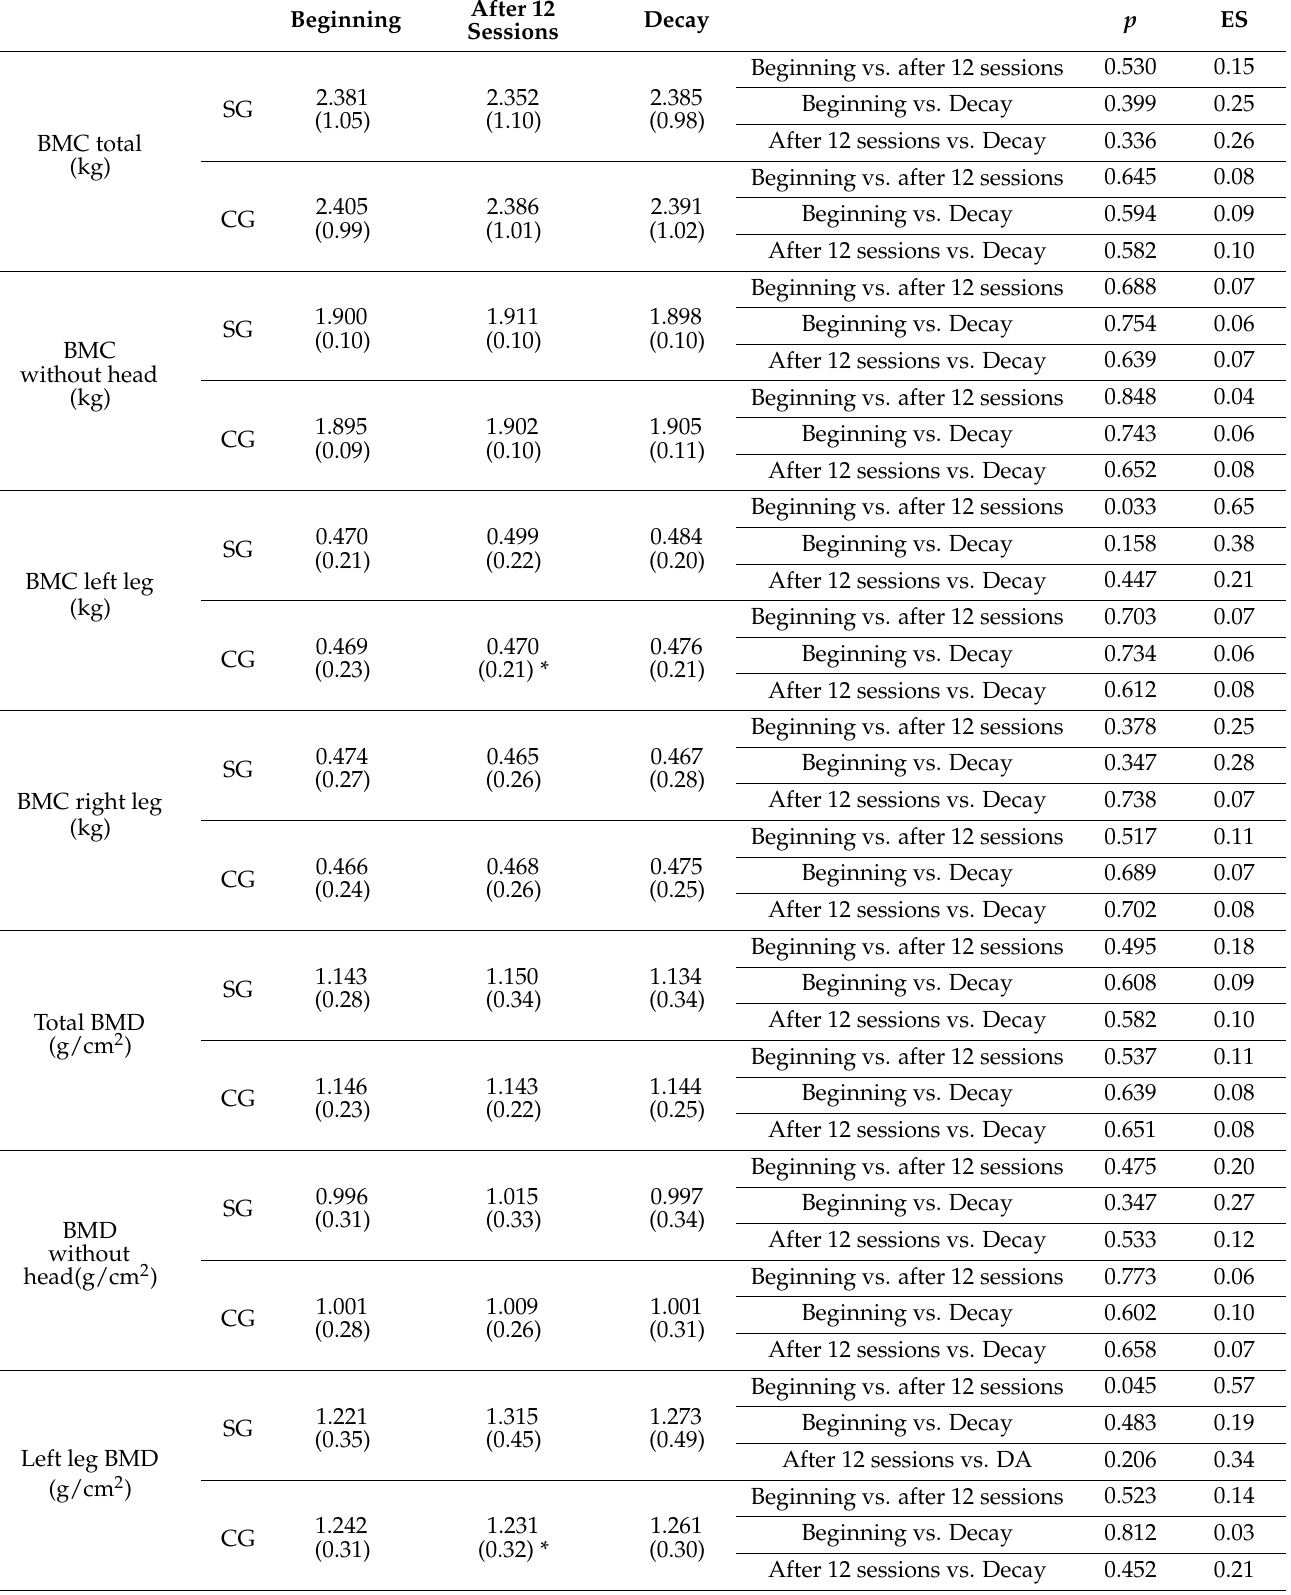
Table 5. Changes in bone parameters during the